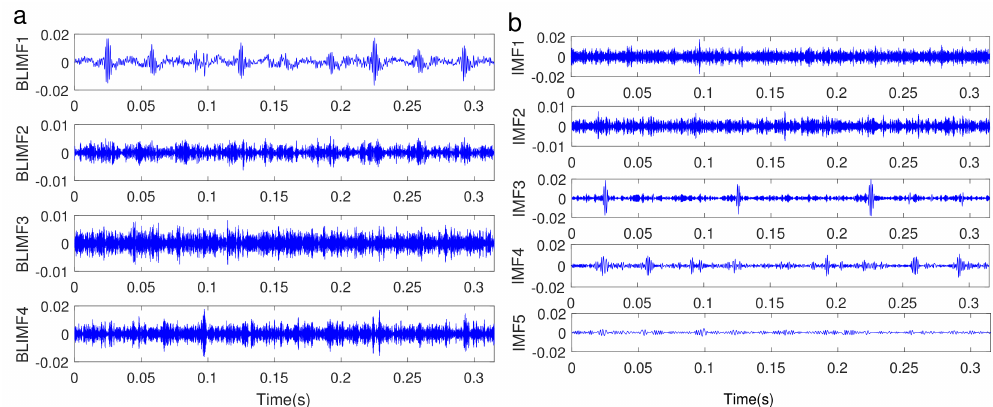
Figure 23. The decomposed BLIMFs using VMD ( a ) and IMFs using EMD ( b ) from the signal of the gear with a broken tooth.